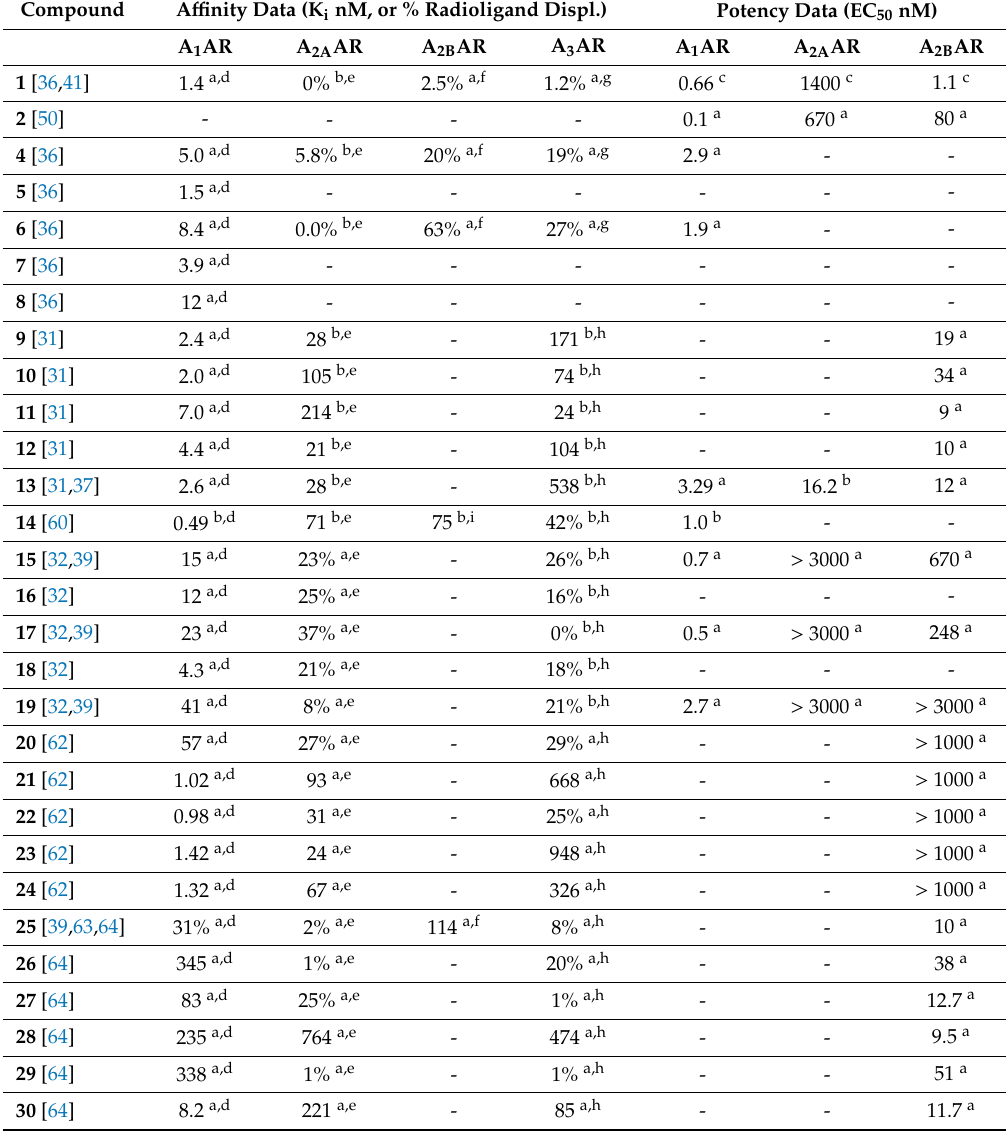
Table 1. Binding a ffi nity (K i ) and potency (EC 50 ) data of selected pyridine-based non-nucleoside agonists of the